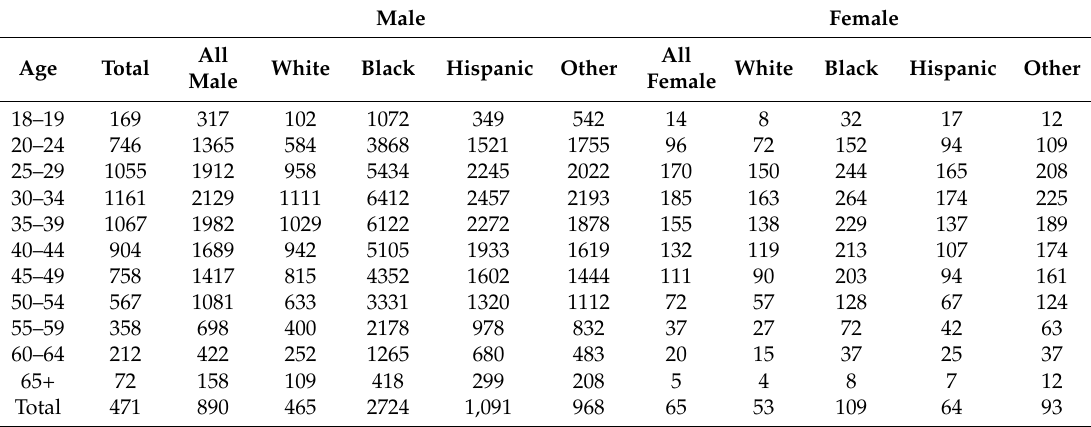
Table 1. Rates of US imprisonment in 2014, by age, sex, and race. Reproduced from Table 10 of Prisoners in 2014